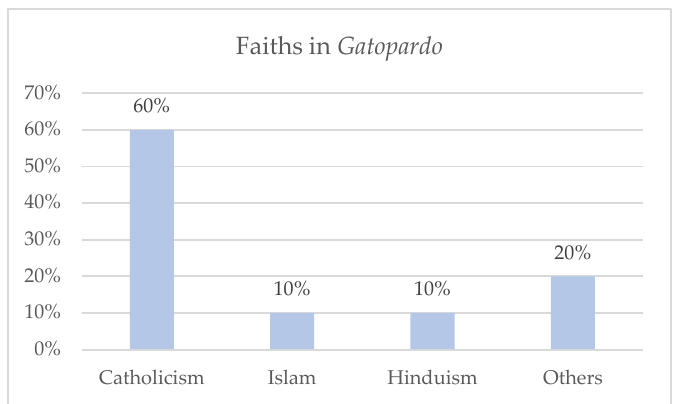
Figure 5. Predominant faiths in articles in Gatopardo .